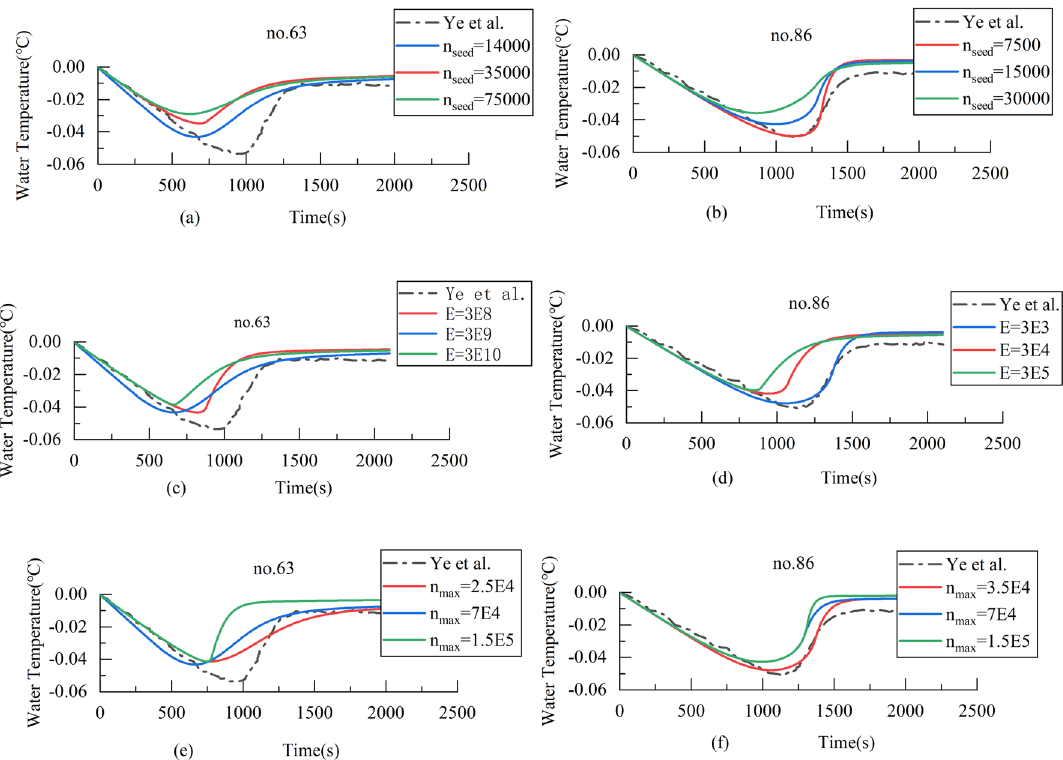
Figure 7. ( a ) Sensitivity analysis of n seed for the laboratory experiment no. 63. ( b ) Sensitivity analysis of n seed for the laboratory experiment no. 86. ( c ) Sensitivity analysis of E for the laboratory experiment no. 63. ( d ) Sensitivity analysis of E for the laboratory experiment no. 86. ( e ) Sensitivity analysis of n max for the laboratory experiment no. 63. ( f ) Sensitivity analysis of n max for the laboratory experiment no.